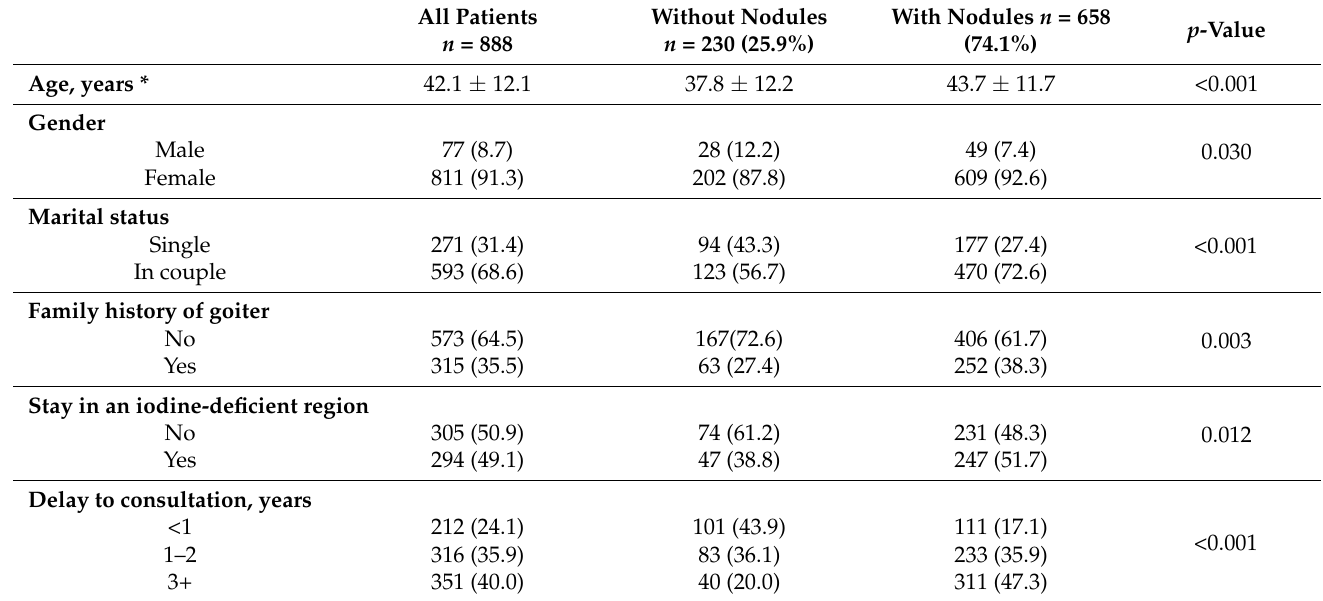
Table 1. Sociodemographic and clinical features of patients with and without